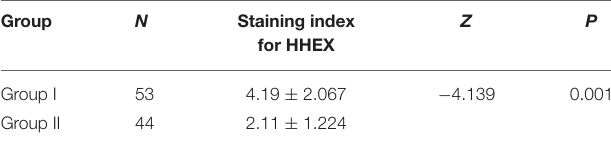
TABLE 2B | The difference of HHEX staining index between among 53 cases of precancerous lesions (group I) and 44 cases of primary BC (group